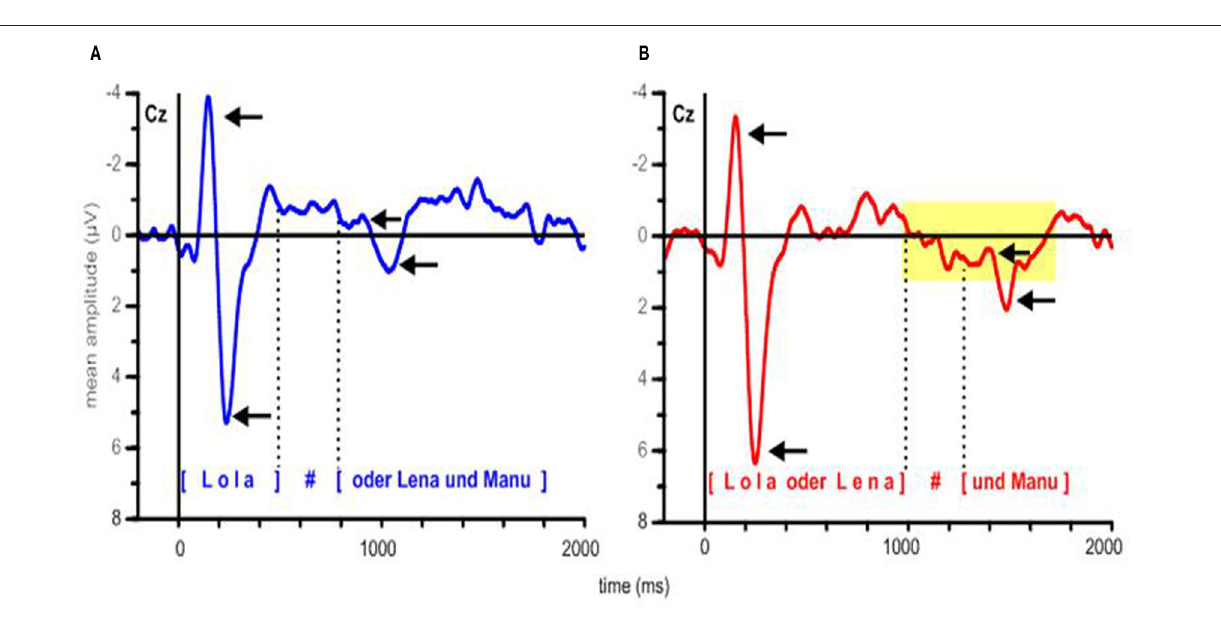
delimit the mean pause intervals; the silent pause is indicated by a hash mark. In panel (B) , the yellow rectangle indicates the time interval in which a positive shift can be observed, starting with pause onset and lasting for approximately